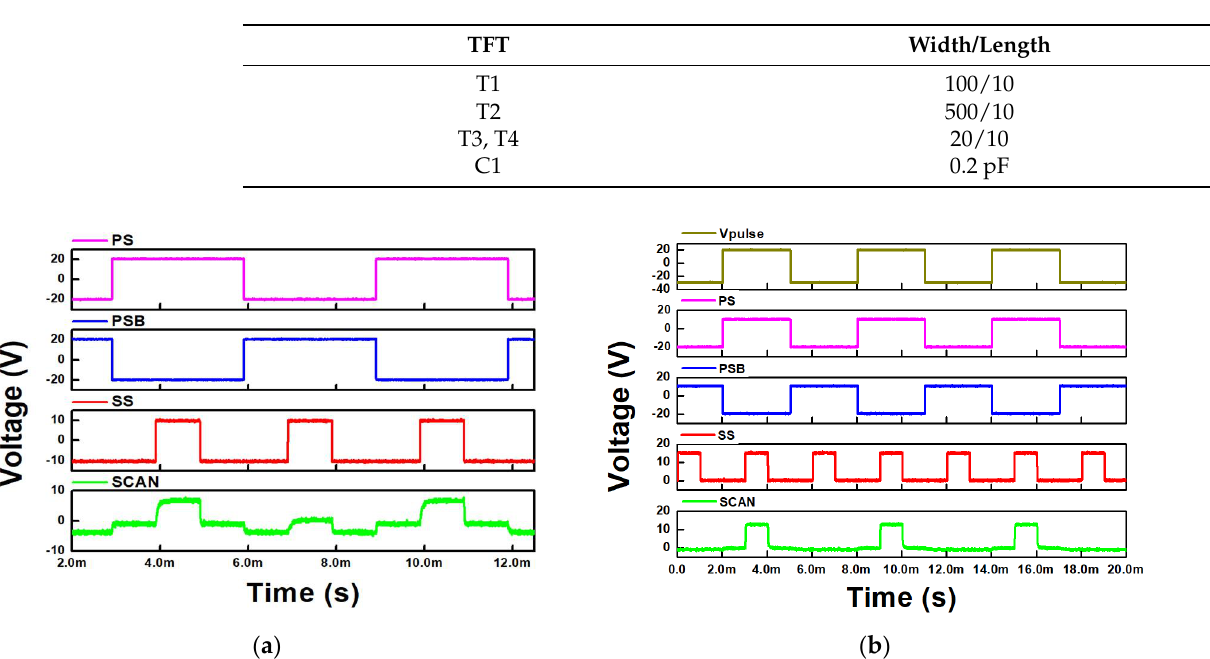
Figure 13. Measured waveforms of the fabricated single-stage drive circuits with TFTs are shown in Figure 10. ( a ) Bootstrap scan driver and ( b ) modified bootstrap scan driver.